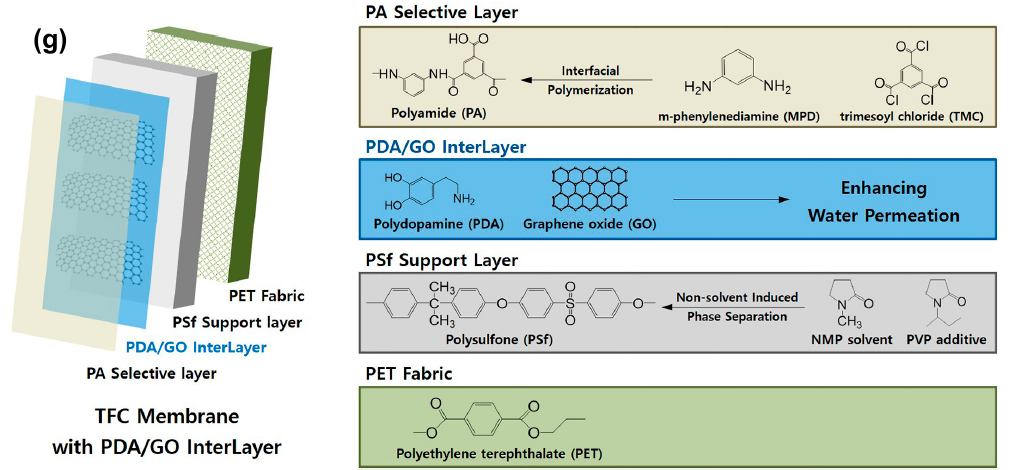
Figure 8. SEM images of surface structures of polysulfone (PSf) support layer membranes with polydopamine/graphene oxide (PDA/GO) interlayer at different concentrations of GO/water solution: